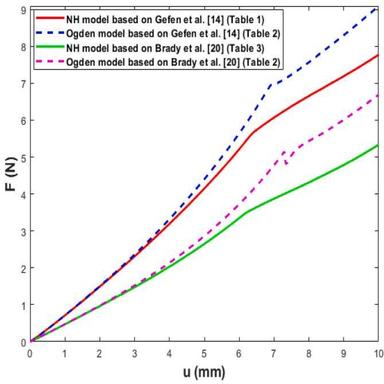
Influence of material nonlinearity of Tunica Albuginea (TA) on the overall response of penile tissue in compression testing.